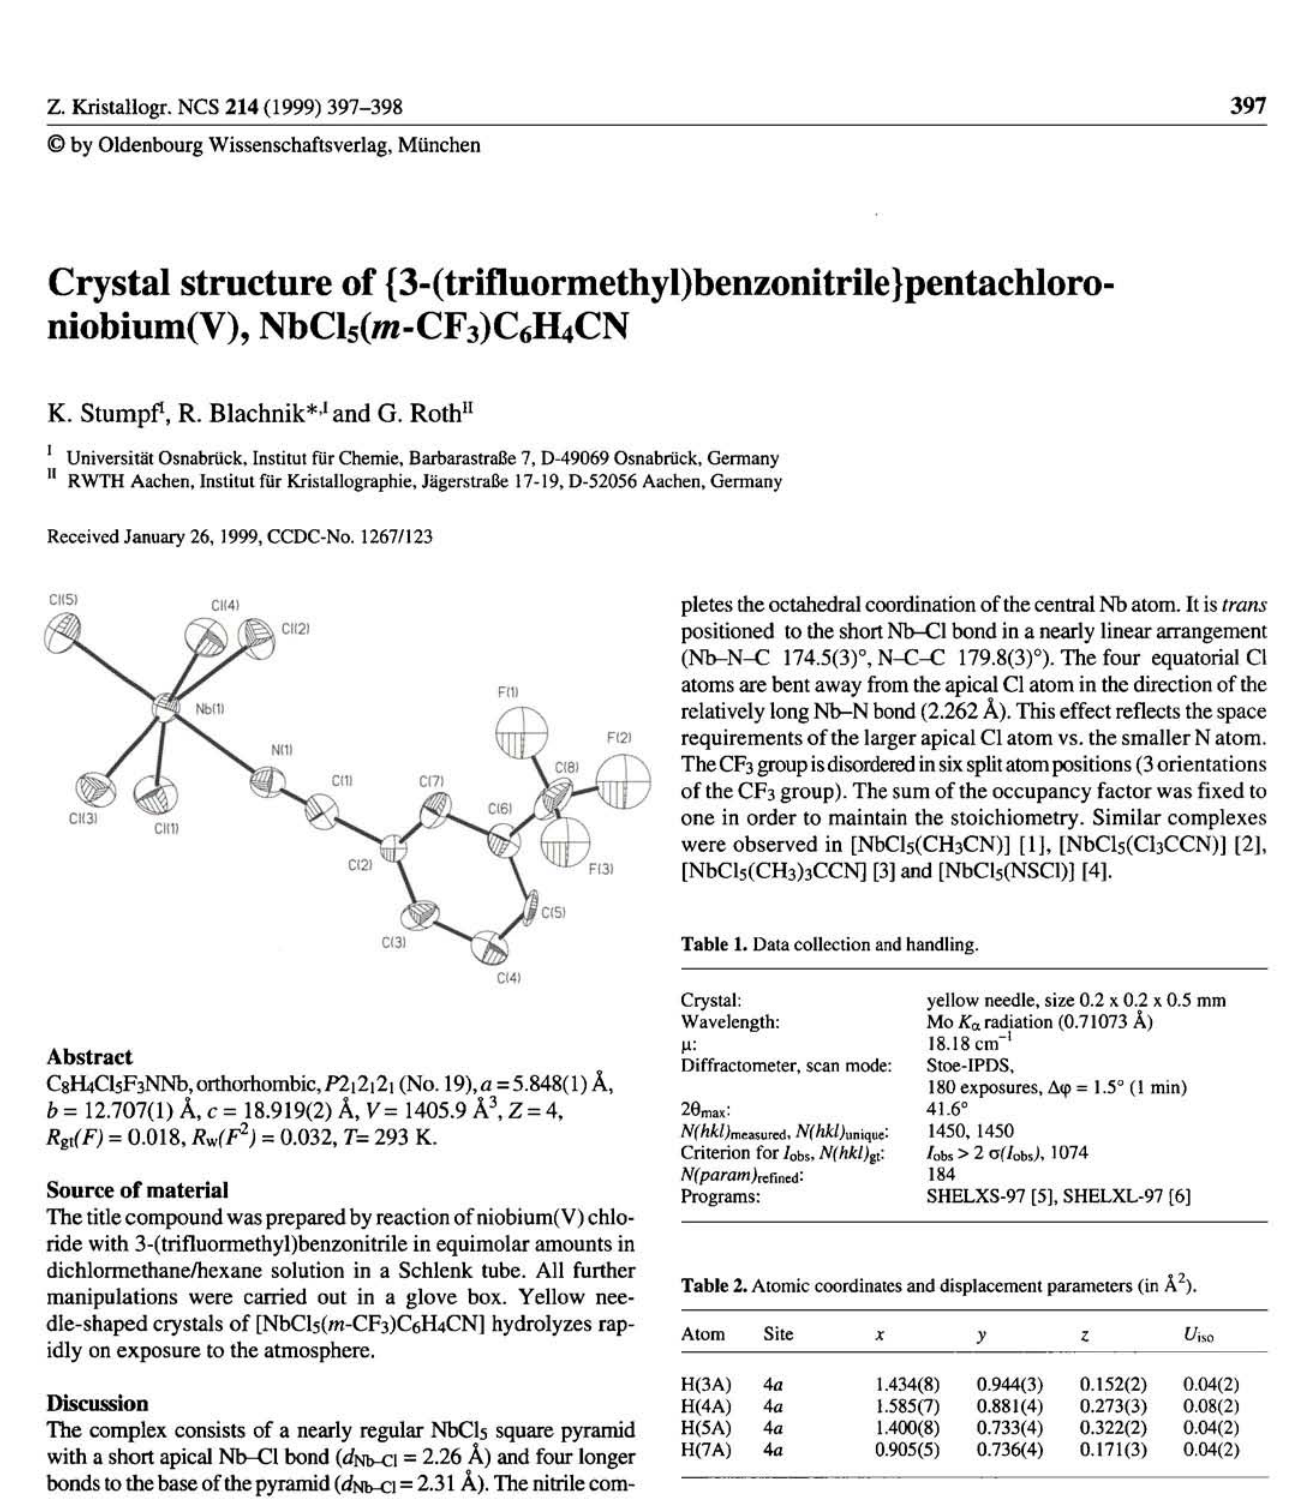
Table 2. Atomic coordinates and displacement parameters (in Â 2